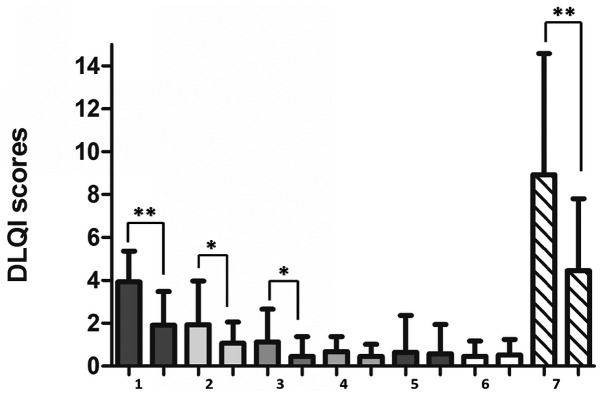
Comparison of dermatology life quality index (DLQI) scores prior to and following the administration of topical minoxidil: 1, symptoms and feelings; 2, daily activities; 3, leisure; 4, work and school; 5, personal relationships; 6, treatment and 7, total score. *P<0.05, **P<0.01, n=31, Student’s paired t-test. Data presented are the means ± SD.